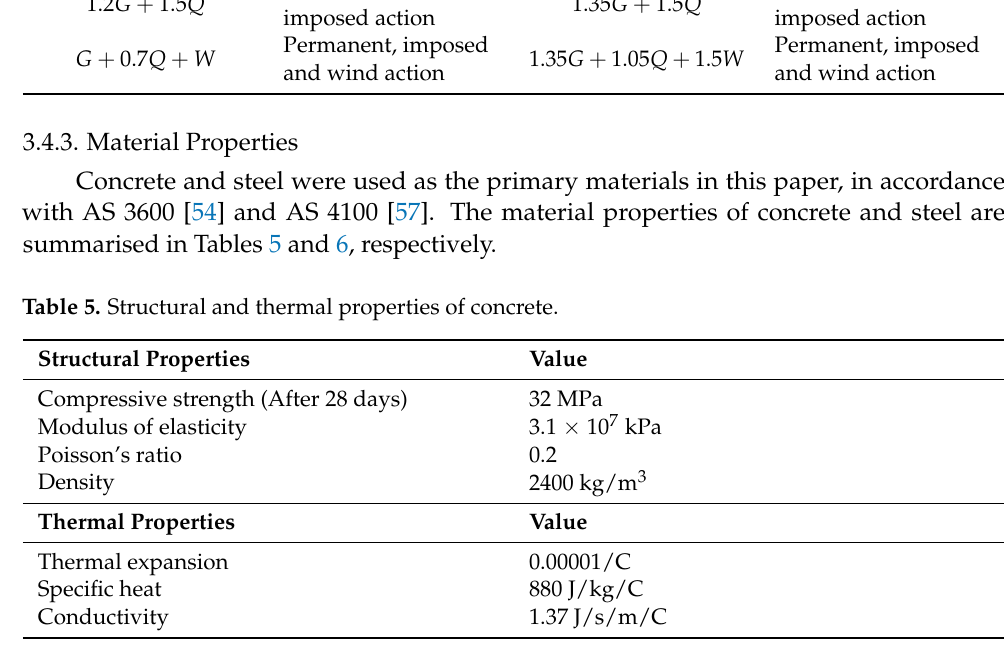
Table 6. Structural and thermal properties of